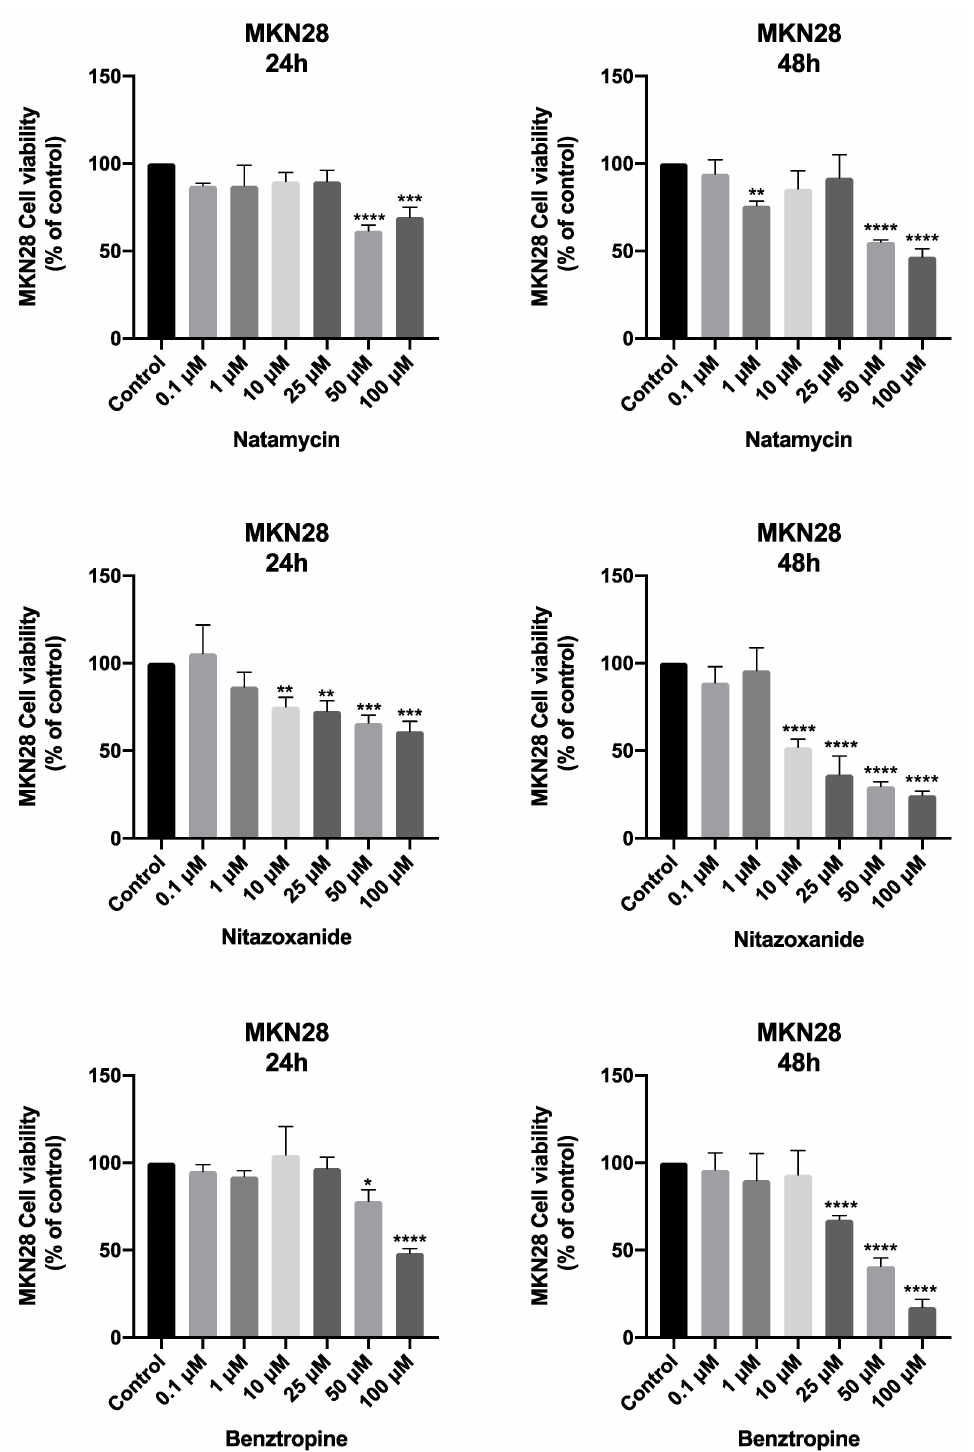
Figure 8. Viability of MKN28 GC cells incubated with different repurposed drugs alone. Cultured cells were seeded in 96-well plates and treated with each drug alone (0.1–100 µ M) for 24 and 48 h. Values are expressed as percentages of control and represent means ± SEM. Each experiment was conducted three times independently ( n = 3); * statistically significant vs. control at p < 0.05; ** statistically significant vs. control at p < 0.01; *** statistically significant vs. control at p < 0.001; **** statistically significant vs. control at p <